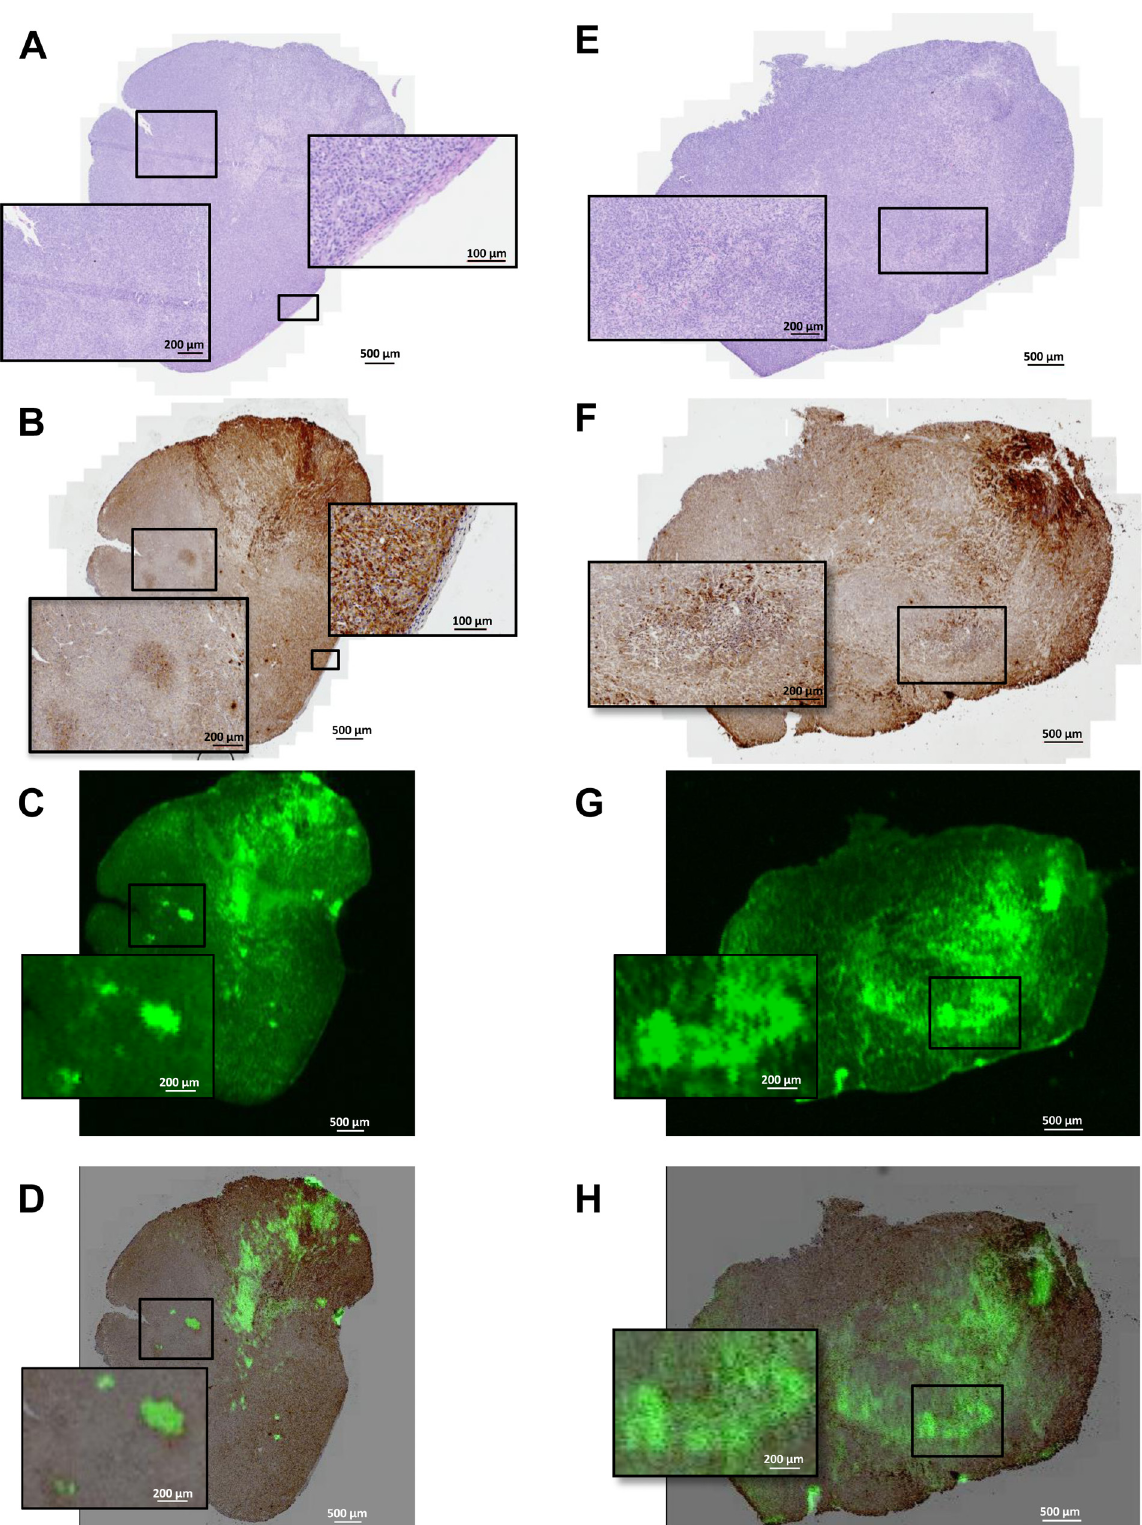
Fig 6. Ex Vivo histology and fluorescence images of s.c. U87MG tumor tissue sections. Shown here is from the top H&E staining (A,E), uPAR staining by immunohistochemistry (B,F), uPAR staining by fluorescence from the injected ICG-Glu-Glu-AE105 (C,G) and merged uPAR IHC and fluorescence